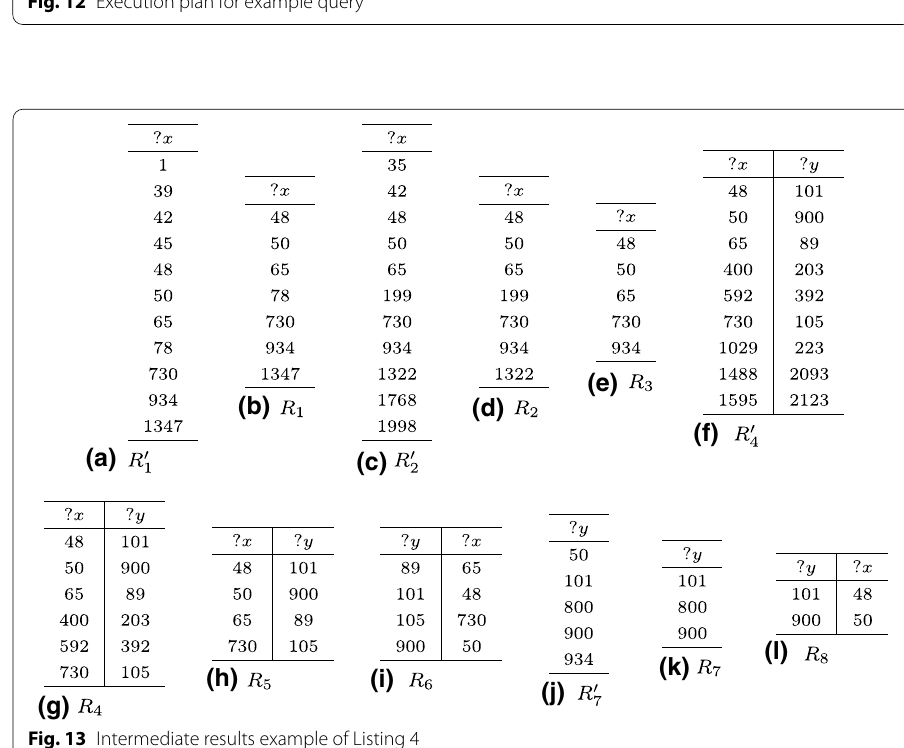
Fig. 12 Execution plan for example query